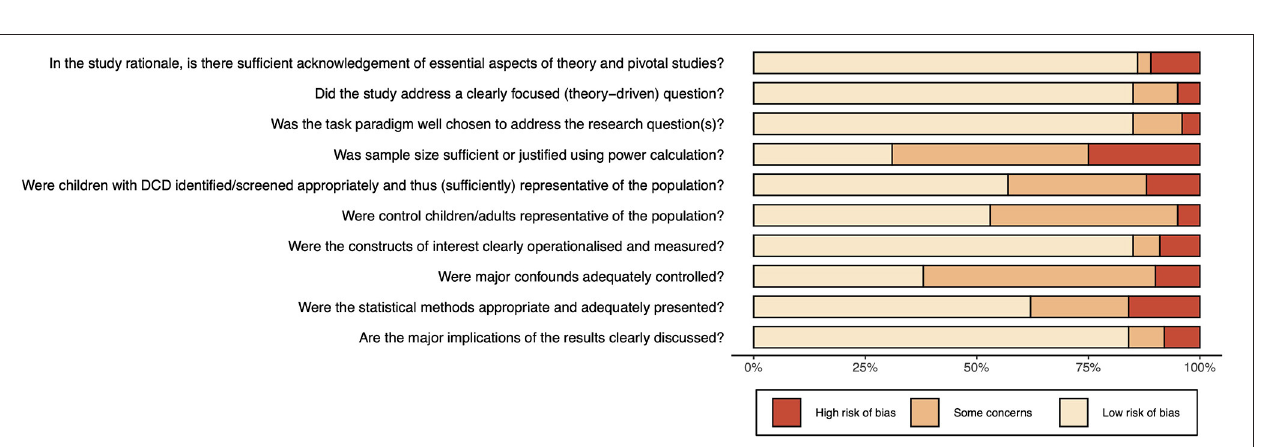
FIGURE 2 | Risk of bias plot using the modified CASP